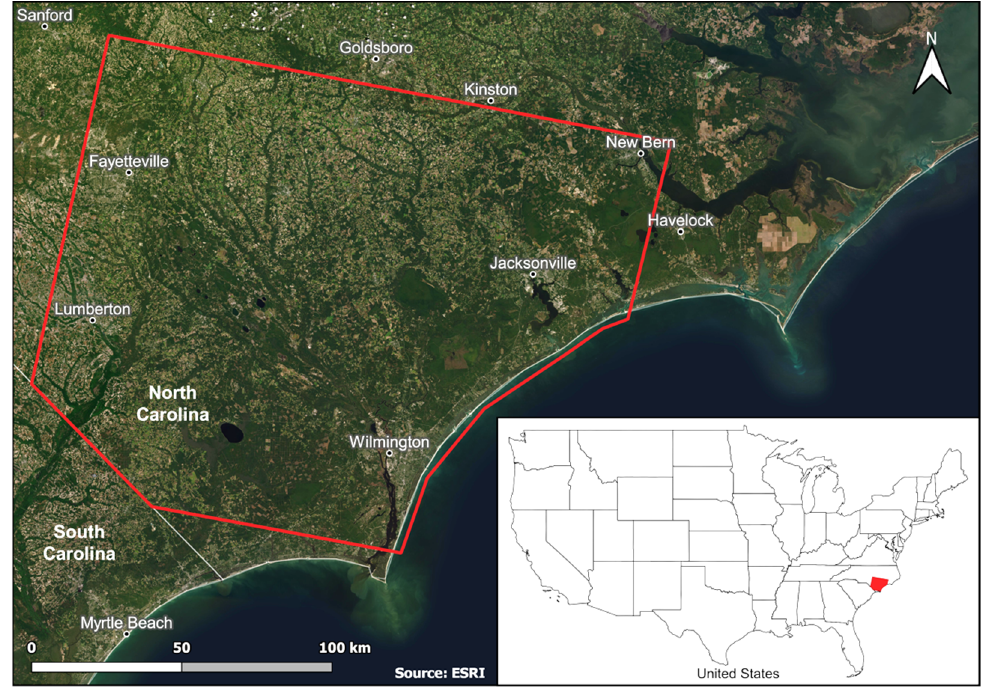
Figure 1. The study area in eastern North Carolina is enclosed by the red line. This area is the extent of one Landsat scene of WGS path = 15, row = 36.